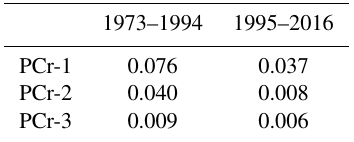
Table 3. Bhattacharyya coefficients applied to different return lev- els, before and after 1994, for each region. Bold values indicate co- efficients below the reference value of 0.61.